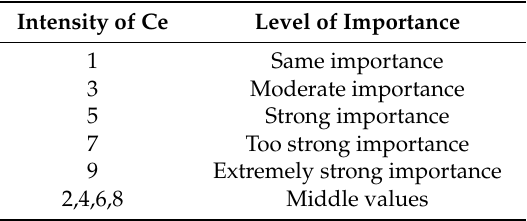
Table 1. Scale from 1 to 9 of absolute number.